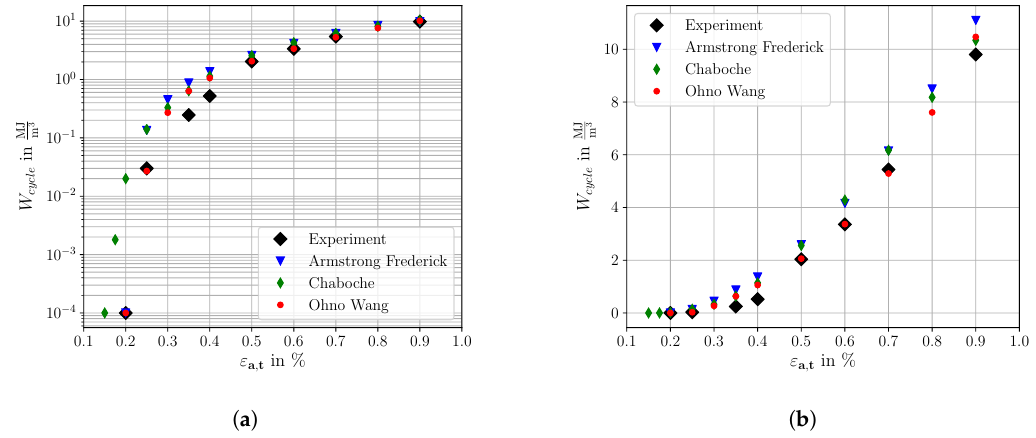
Figure 13. Plastic strain energy density characteristics for three different kinematic hardening models and experimental data of SAE 4150 at R ε = 1; ( a ) with logarithmic y-axis ( b ) with linear −